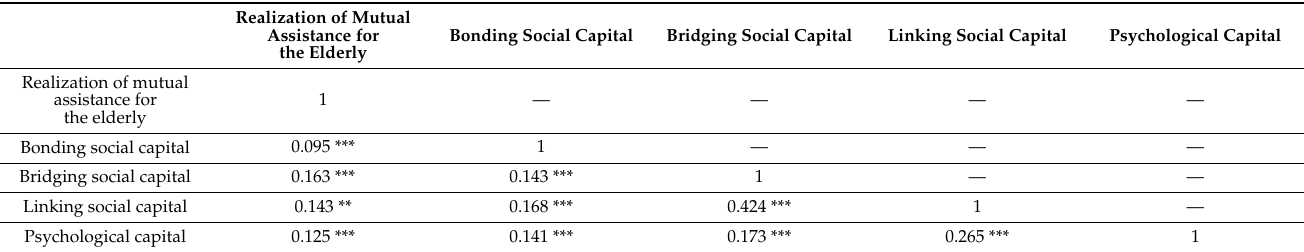
Table 4. Correlation test of core variables.